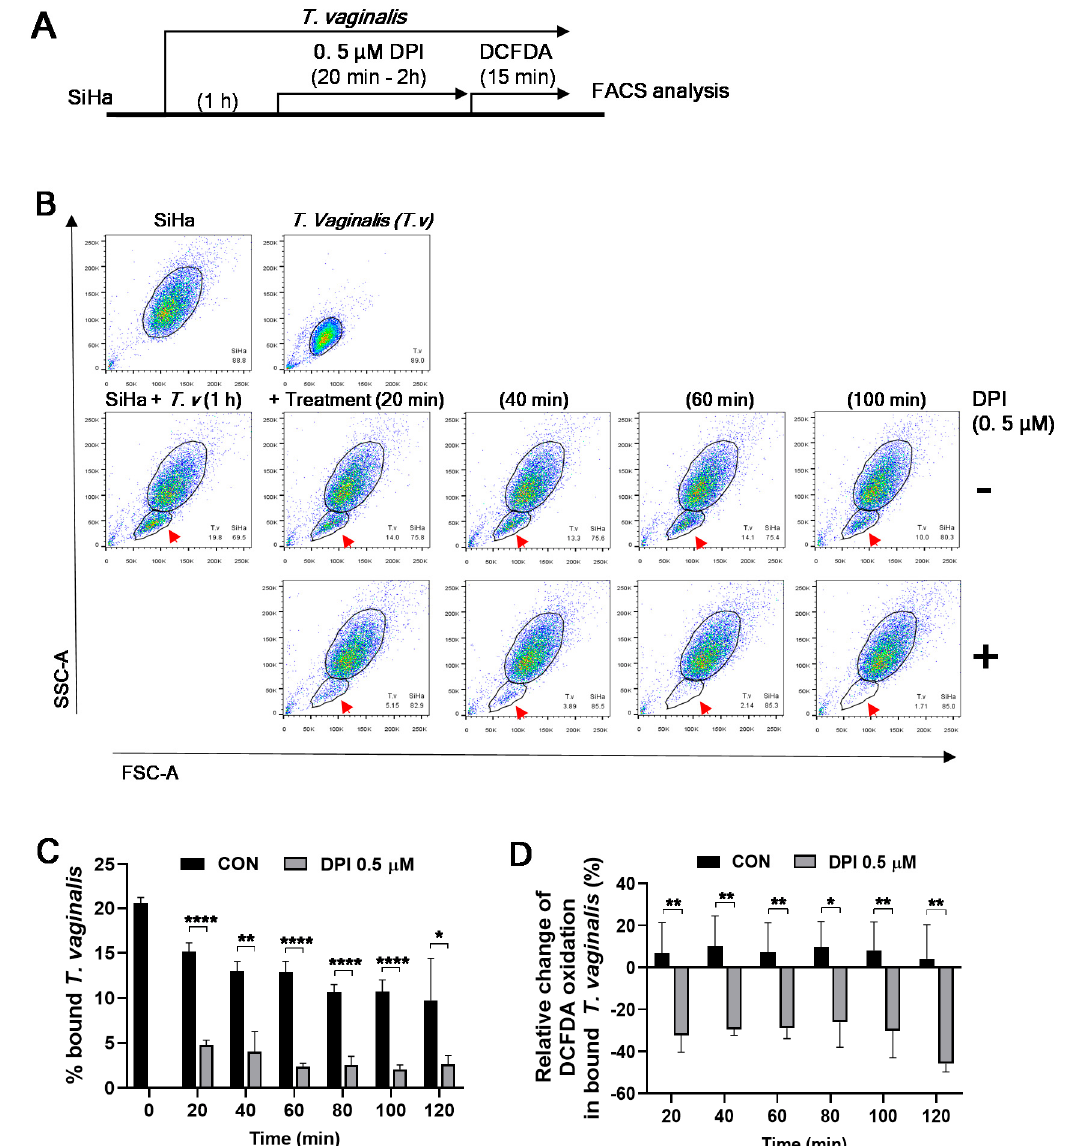
Figure 5. Kinetics of DPI-induced detachment of T. vaginalis from SiHa cells. ( A ) Experimental scheme: SiHa cells were infected with T. vaginalis for 1 h and treated with 0.5 µ M DPI for the indicated durations. The mixed culture was incubated with 1 µ M CM-H 2 DCFDA prior to trypsinization and flow cytometric analysis. ( B ) The FSC-A / SSC-A dot plot of SiHa cells and T. vaginalis . Attached T. vaginalis populations are indicated by red arrows. ( C ) Bound T. vaginalis levels were quantified from flow cytometry data ( n ≥ 3). ( D ) Relative change of CM-H 2 DCFDA oxidation in the bound T. vaginalis . Mean ± SD. * p < 0.05, ** p < 0.01, **** p < 0.0001. Statistical di ff erence by unpaired t -test compared to no treatment controls (CON). Data are representative of at least three independent experiments.